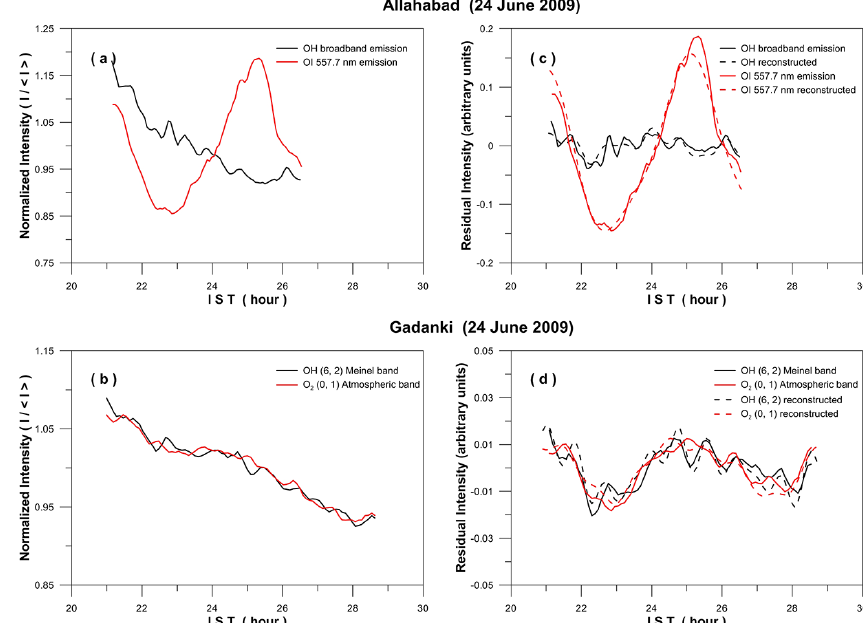
Figure 5. Nocturnal variation of different emission features over Allahabad and Gadanki on 24–25 June 2009: (a) and (b) depict the behaviour of normalized intensity at Allahabad and Gadanki, respectively, while the variation of residual intensity is shown in (c) and (d) . The broken curves represent the intensity series reconstructed using different spectral